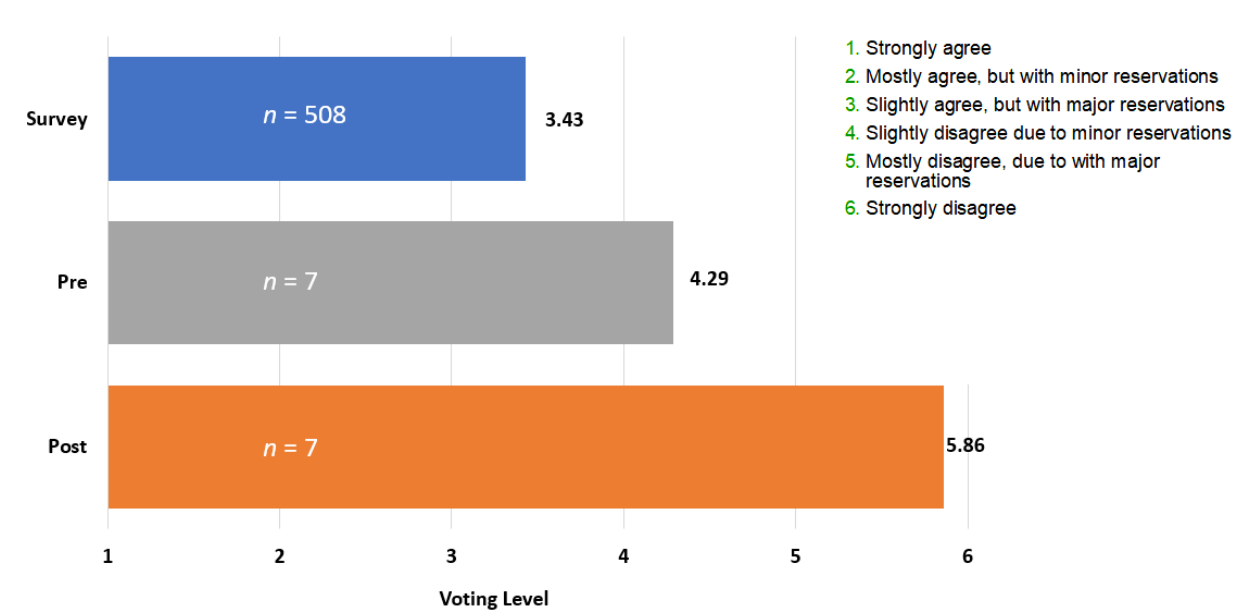
Figure 2. Mean Voting level for the statement “No insomnia medication should be used on a daily basis for durations longer than 3 weeks at a time”. Survey participants n = 508, 7 expert panelists voted before the literature search on the statement and post-presenting of the literature. 1 = strongly agree, 2 = mostly agree but with minor reservations, 3 = slightly agree but with major reservations, 4 = slightly disagree, due to minor reservations, 5 = mostly disagree, due to major reservations, 6 = strongly disagree.